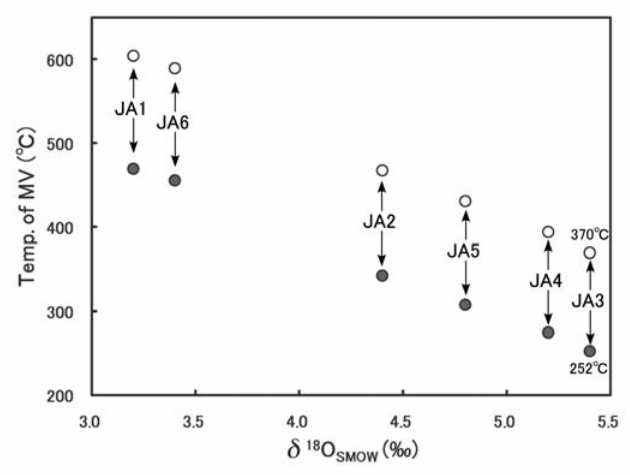
Figure 9. Estimated temperatures of the MV. Filled, open circles, estimates assuming δ 18 O for magmatic vapor of + 7‰ and + 8.5‰,